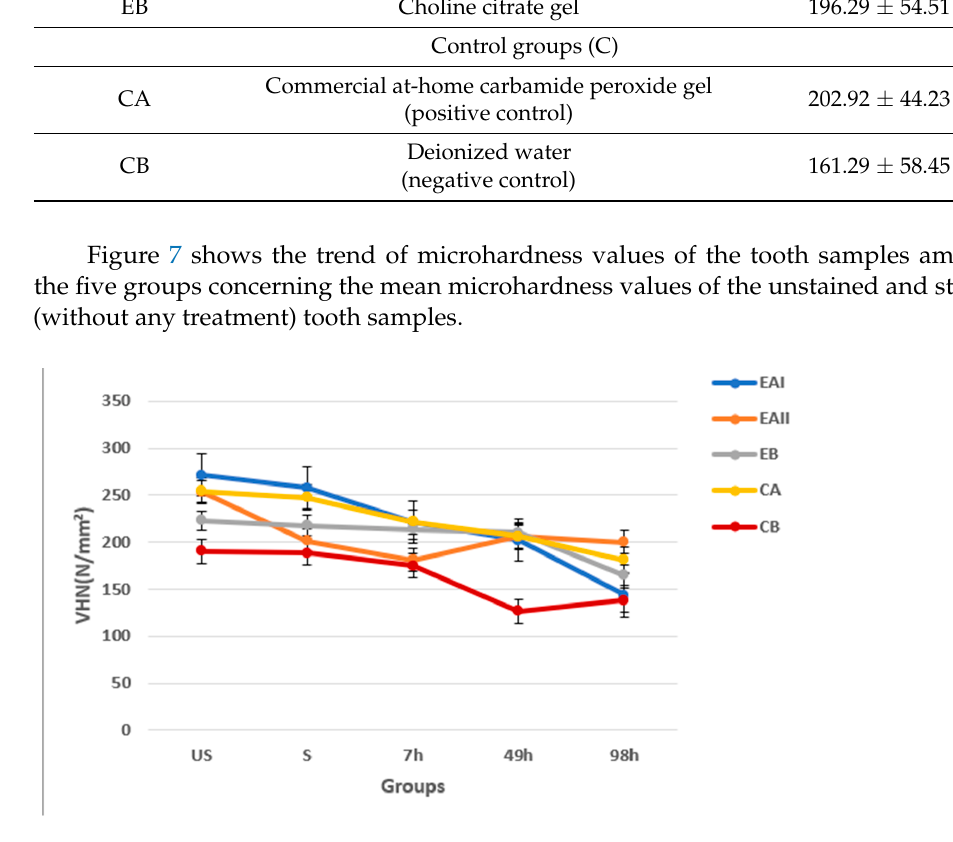
Figure 7. Trend of microhardness across groups in comparison to the Unstained (US) and Stained (S) tooth samples. A progressive decrease in microhardness across the five groups while moving from the Unstained tooth sample to 98 h treatment in duration.